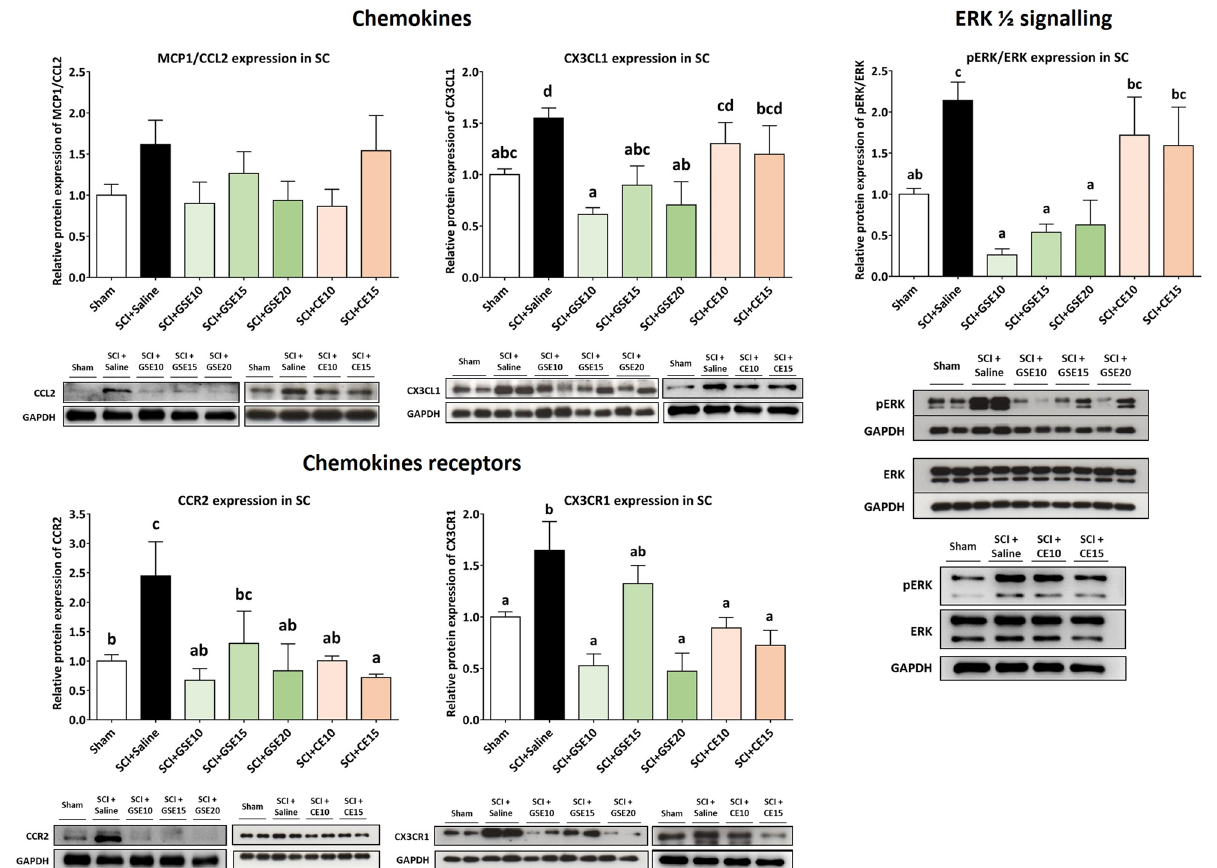
Figure 7. Spinal expression of chemokines (MCP1/CCL2 and CX3CL1) and their receptors (CCR2 and CX3CR1) and spinal levels of ERK phosphorylation after preventive GSE and CE treatment in spinal cord- injured mice at the end of the experimental period. Protein expression was normalized to GAPDH. Data are expressed as a relative percentage with respect to the sham group (mean ± SEM). a–d: Groups not sharing a letter showed significant differences, p < 0.05. Experimental groups: Sham (MCP1/CCL2 n = 9; CCR2 n = 10; CX3CL1 n = 9; CX3CR1 n = 8; pERK/ERK = 9), SCI + Saline (MCP1/CCL2 n = 9; CCR2 n = 9; CX3CL1 n = 8; CX3CR1 n = 7; pERK/ERK = 8), SCI + GSE10 (MCP1/CCL2 n = 5; CCR2 n = 5; CX3CL1 n = 4; CX3CR1 n = 4; pERK/ERK = 4), SCI + GSE15 (MCP1/CCL2 n = 5; CCR2 n = 5; CX3CL1 n = 4; CX3CR1 n = 4; pERK/ERK = 4), SCI + GSE20 (MCP1/CCL2 n = 5; CCR2 n = 5; CX3CL1 n = 4; CX3CR1 n = 4; pERK/ERK = 4), SCI + CE10 (MCP1/CCL2 n = 4; CCR2 n = 5; CX3CL1 n = 5; CX3CR1 n = 5; pERK/ Control images were reused either